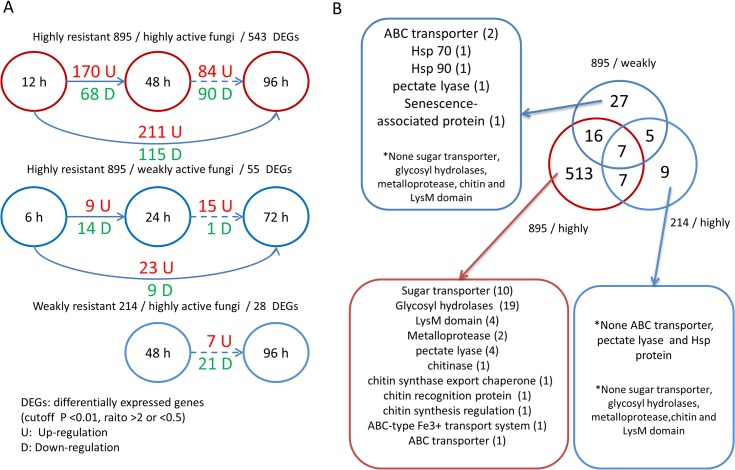
The characteristics of 584 DEGs in dynamic transcriptome analysis suggested intense rivalry in the highly resistant 895/highly active fungus group.(A) The differentially expressed fungal genes between different time points in three groups. (B) The overlapping and specific DEGs among the three groups. The numbers in the brackets represent the number of DEGs belonging to the annotation.